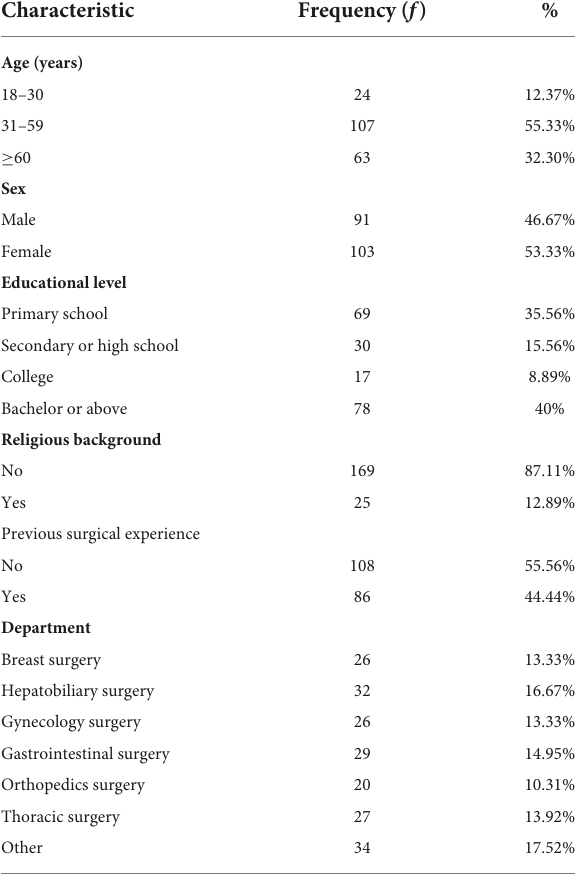
TABLE 3 The characteristics of the participants ( N = 194).